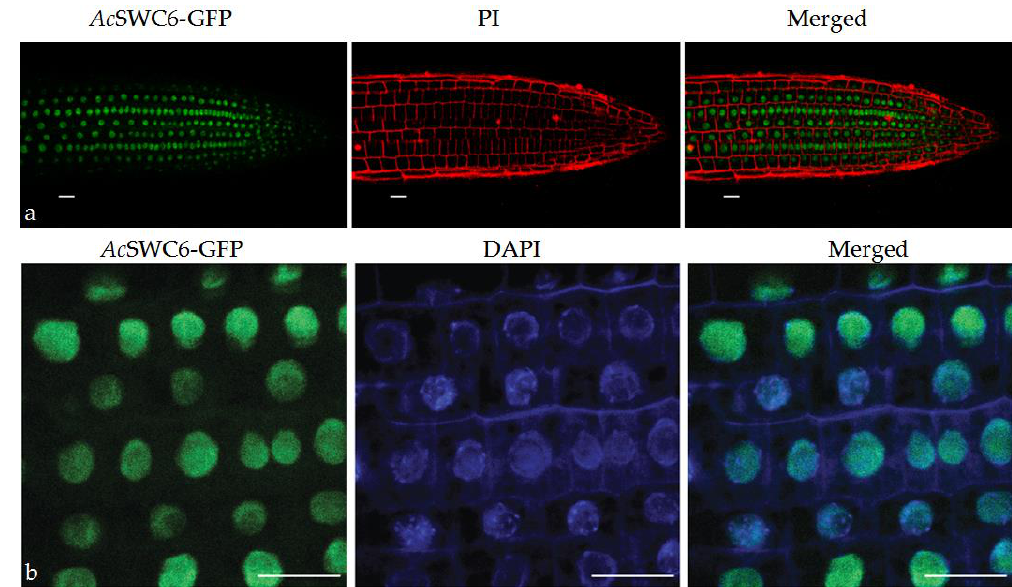
Figure 6. Ac SWC6-GFP localizes to the nucleus. ( a ) Ac SWC6-GFP localization in the nucleus of seven-day-old roots of transgenic Arabidopsis plants. GFP fluorescence is represented in green and propidium iodide (PI) fluorescence channel is represented in red ( b ) Ac SWC6-GFP localization in the nucleus of seven-day-old roots of transgenic Arabidopsis plants. GFP fluorescence is represented in green and DAPI fluorescence channel is represented in blue. Scale bars = 20 µ m. Biomolecules 2019 , 9 , x